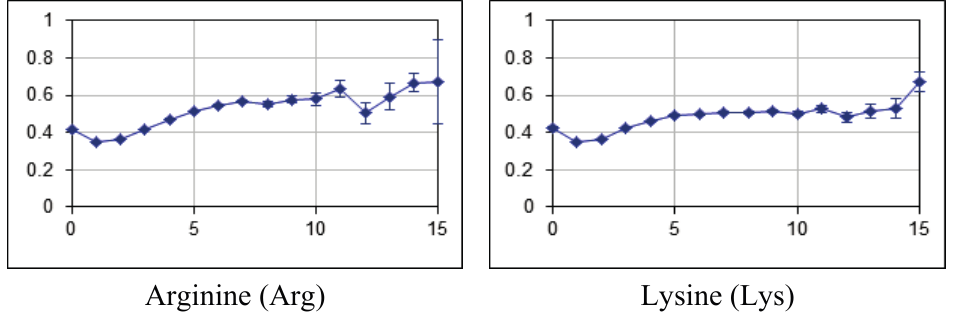
Figure 8. Fraction of disordered residues for proteins containing homo-repeats tabulated for all 20 amino acids. Average fraction of disordered residues versus the length of the homo-repeat is plotted for hydrophobic, small, polar and charged amino acids as indicated.